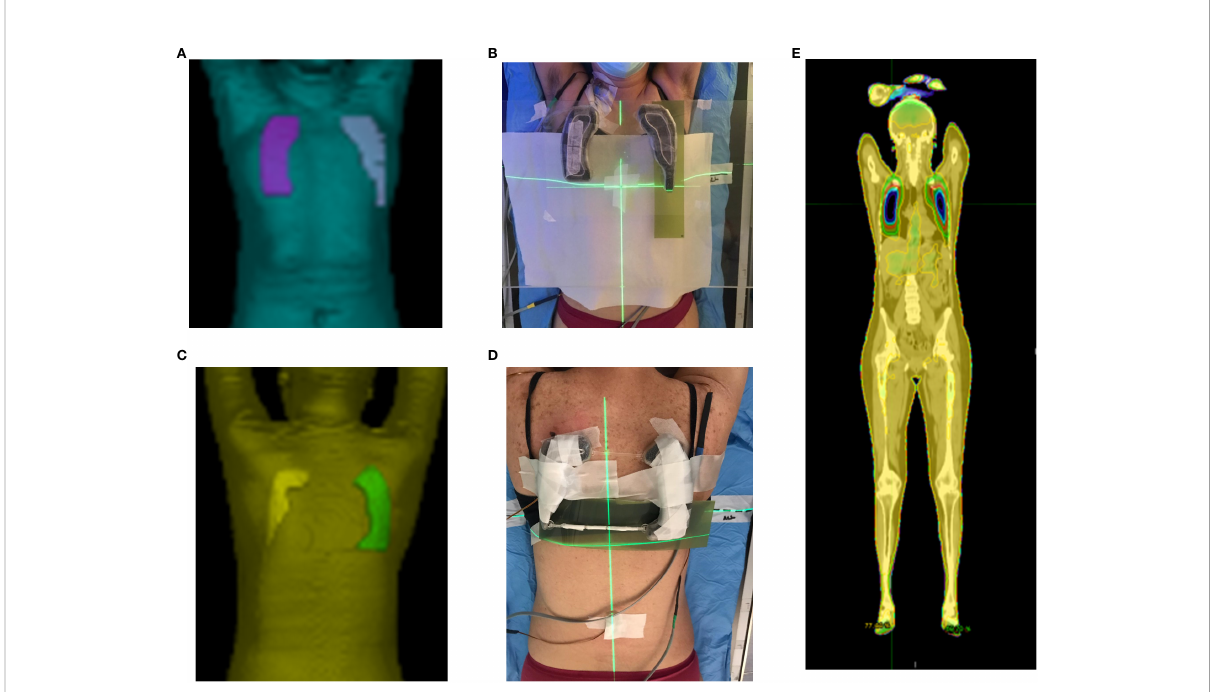
FIGURE 7 Planned (A, C) and printed (B, D) lung blocks for the supine (A, B) and prone (C, D) treatment position. The supine lung blocks were placed over the dedicated block tray while those for prone position setup were placed on patient skin. MOSFETs and Gafchromic fi lms are also shown in panel (B, D, E) . Accumulated dose distribution on the supine